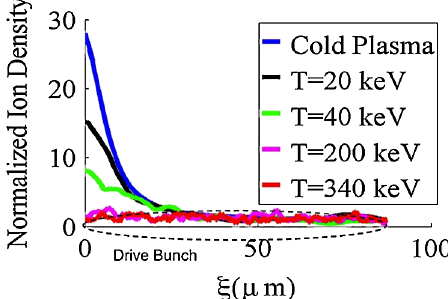
FIG. 3. On-axis plasma ion densities along drive bunch ( (cid:2) z ¼ 35 (cid:5) m ) traveling to the right for various plasma ion tempera- tures obtained from simulations with mobile ions after 40 cm of plasma. The ion density in the back of the bunch decreases to the immobile ion value as the plasma ion temperature increases. Initial plasma density is n e ¼ 0 : 9 (cid:3) 10 16 cm (cid:1) 3 . The (cid:7) 1 : 25 (cid:2) z contour of the beam is shown schematically. Effective length of the beam is assumed 2 : 5 (cid:2) z .